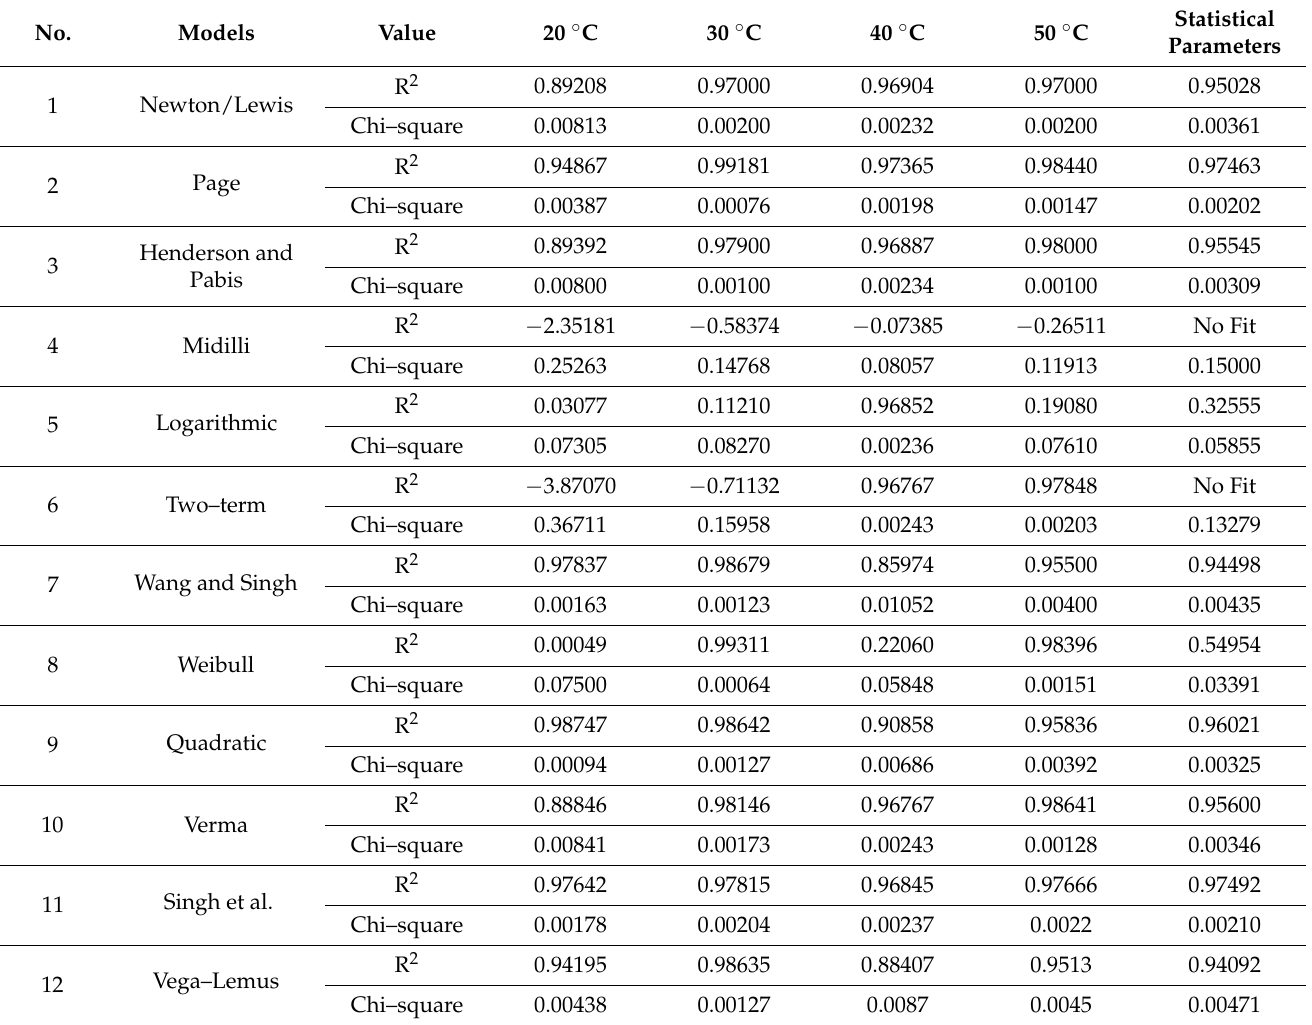
Table 2. Statistical parameters of the different